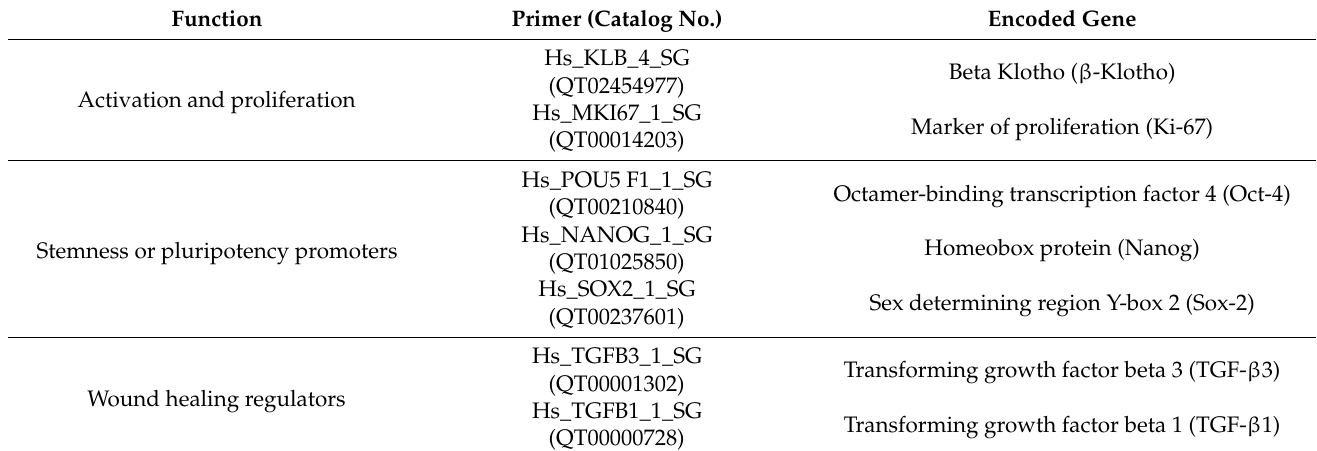
Table 1. List of functional genes associated with ADSCs’ growth and development.